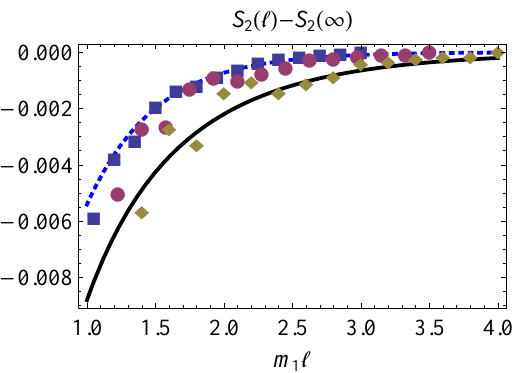
Figure 6: The function (51) (solid curve), compared to TCSA results obtained in [ 7 ] for a L = 8 (rombi), m L = 7 (circles) and m L = 6 (squares) and to the fit system of length m 1 1 1 (60) (dashed